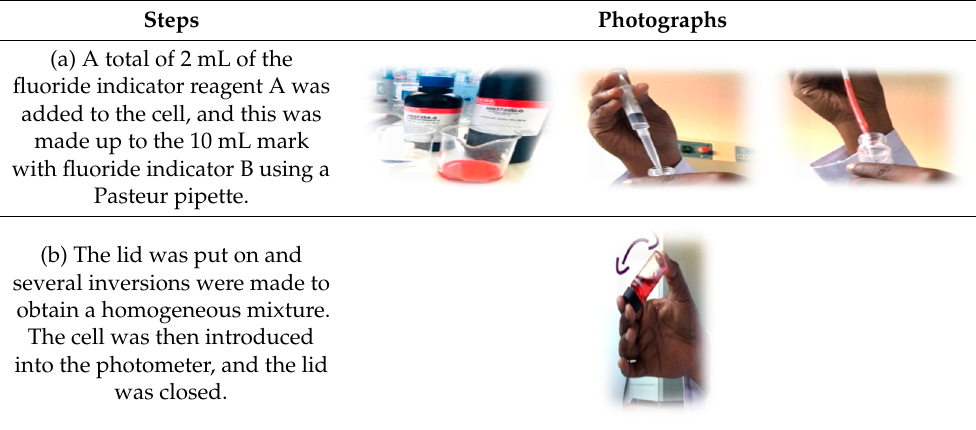
Table 1. Description of the procedure for fluoride determination.